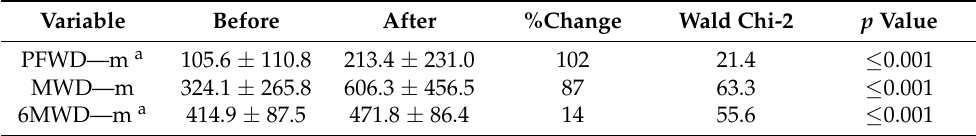
Table 2. Treadmill performance and 6 min walking distance before and after supervised exercise training. Variable Before After